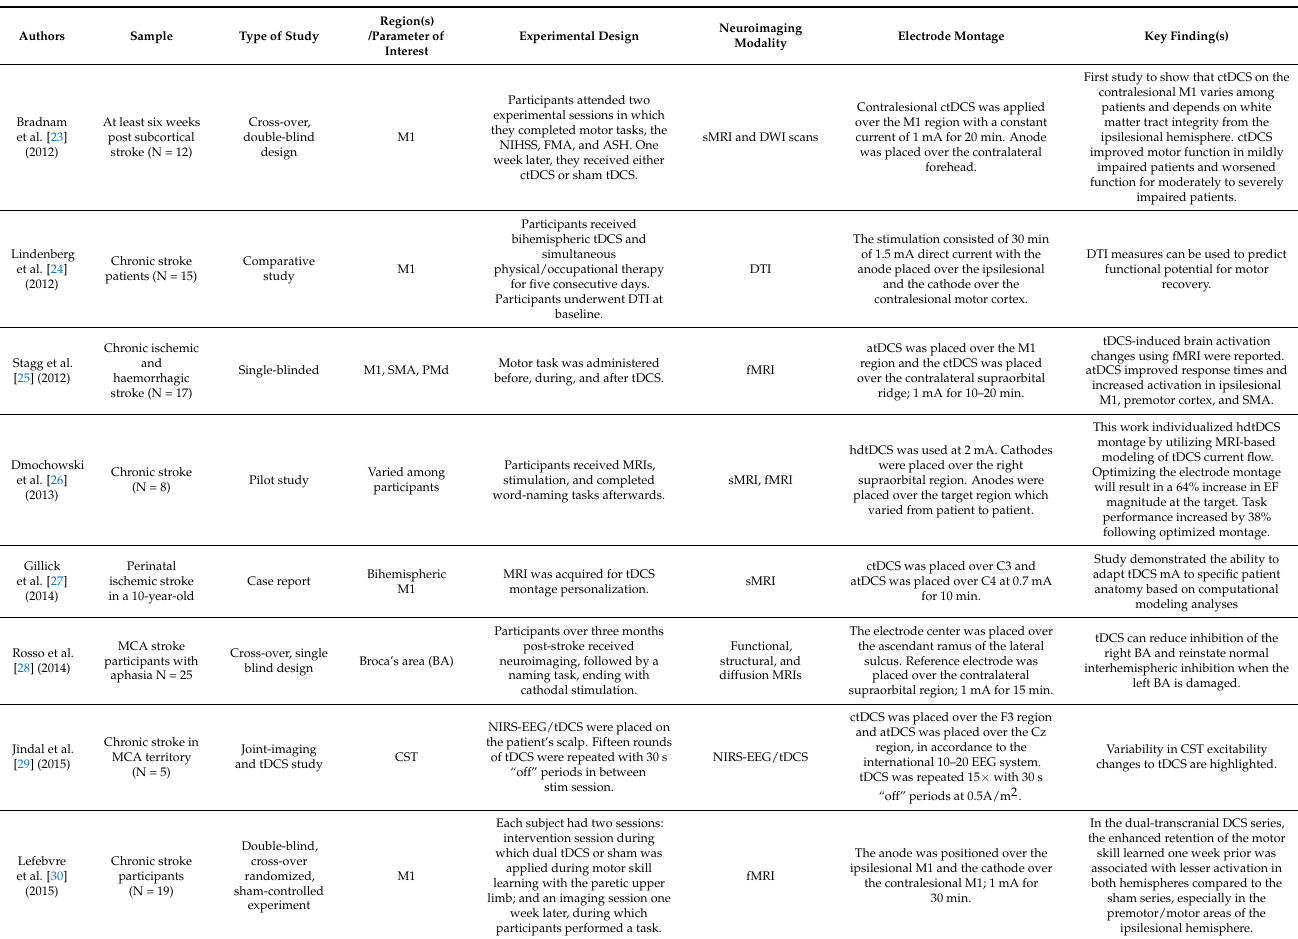
Figure 1. Brief timeline of tDCS. The number of publications per year was calculated in PubMed using the following keyword search: “transcranial direct current stimulation” or “tDCS” [9,16,17,19–22]. Table 2. Human studies that incorporated tDCS and MRI.